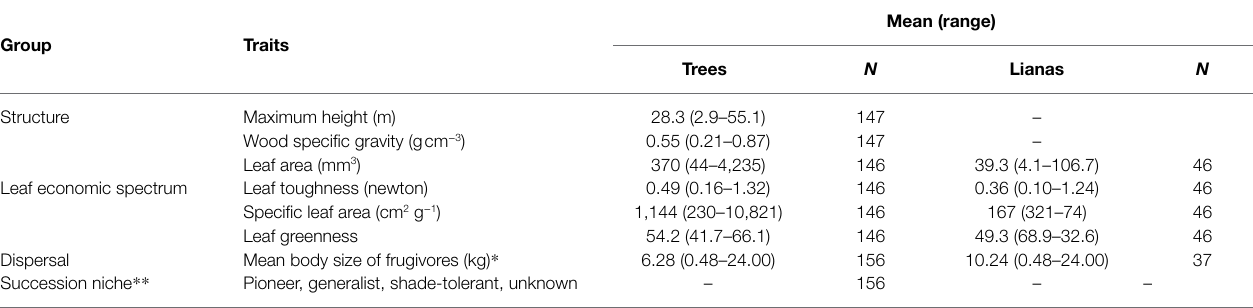
TABLE 1 | Mean and ranges of values of all traits with available data ( N : number of species).